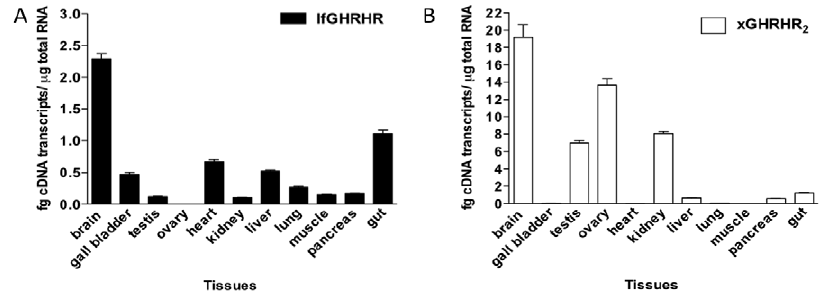
Figure 3. Tissue distribution profile of lfGHRHR and xGHRHR2. Gene expression of (A) lfGHRHR in P. dolloi and (B) xGHRHR 2 in X. laevis was assessed by quantitative real-time PCR. The expression level of each gene was calculated from respective standard curve. Data are expressed as mean 6 SEM (n=4). Highest expression for both GHRH receptors was detected in the brain, as observed in mammals.